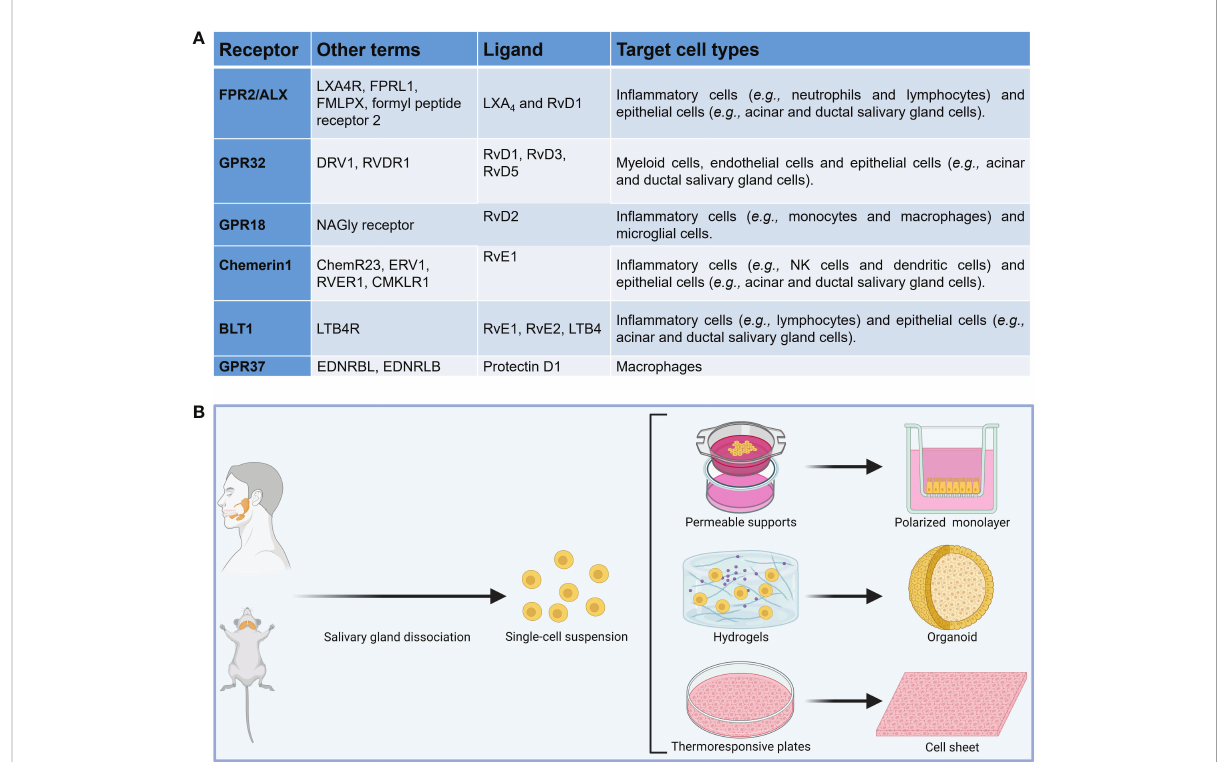
FIGURE 1 (A) Summary of SPM receptors, ligands and target cell types implicated in the resolution of in fl ammation. (B) Diagram showing common in vitro models to investigate the impact of specialized pro-resolving lipid mediators in salivary